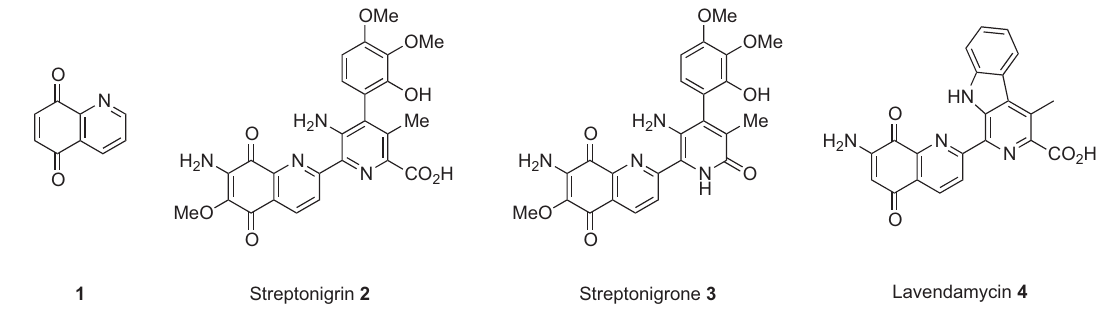
Figure 1 . Quinolinequinone derivatives.